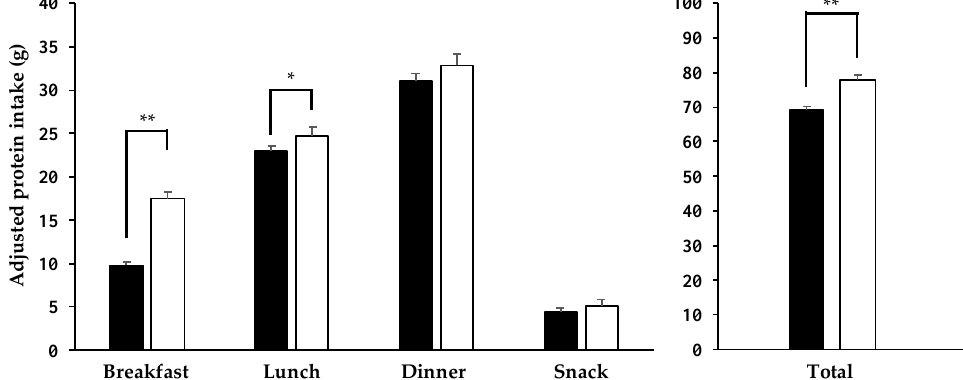
Figure 3. Adjusted protein intake at each meal and in total between the AP ( ☐ : n = 83) and NP ( ■ : n = 153) groups. AP group, achieving over 0.24 g/kg BW of protein intake at all three meals; NP group, not achieving 0.24 g/kg BW of protein intake from at least one meal. Values are expressed as means ± SE, and adjusted for age, sex, drinking habit, smoking habit, living condition (alone or with family), PSQI, MEQ, and IPAQ scores, and total energy intake with residual methods [7]. *: p <0.05, **: p < 0.001. Abbreviations: BW, Body Weight; PSQI, Pittsburgh Sleep Quality Index; MEQ, Morningness– Eveningness Questionnaire; IPAQ, International Physical Activity Questionnaire. 3.6. Comparison of FFM between AP and NP Groups with Total Protein Intake more than the RDA After adjusting for total energy intake with residual methods [7], we selected the subjects with total protein intake more than the RDA and divided them into the AP ( n = 83) and NP ( n = 153) groups With adjustment for age, sex, drinking habit, smoking habit, living condition, MEQ, PSQI, and IPAQ scores, the AP group had significantly higher TotalFFM% than the NP group (75.2 ± 0.4 vs. 77.0 ± 0.5, p = 0.008), while AppFFM% was possibly higher in the AP group than in the NP group (34.1 ± 0.2 vs. 34.7 ± 0.3, p = 0.058) in Figure 4.